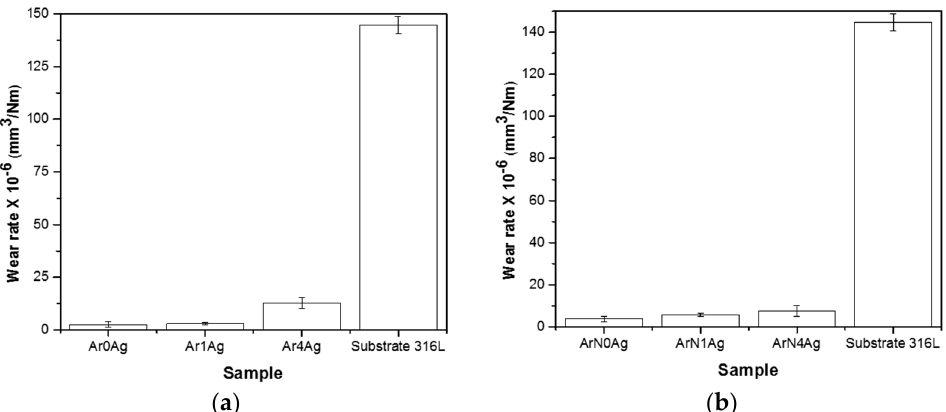
Figure 8. Values of wear rate of the coating deposited: ( a ) inert atmosphere; ( b ) reactive atmosphere.